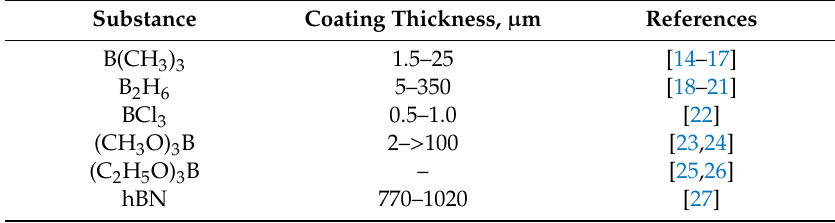
Table 1. Frequently used doping diamond boron-containing substances.